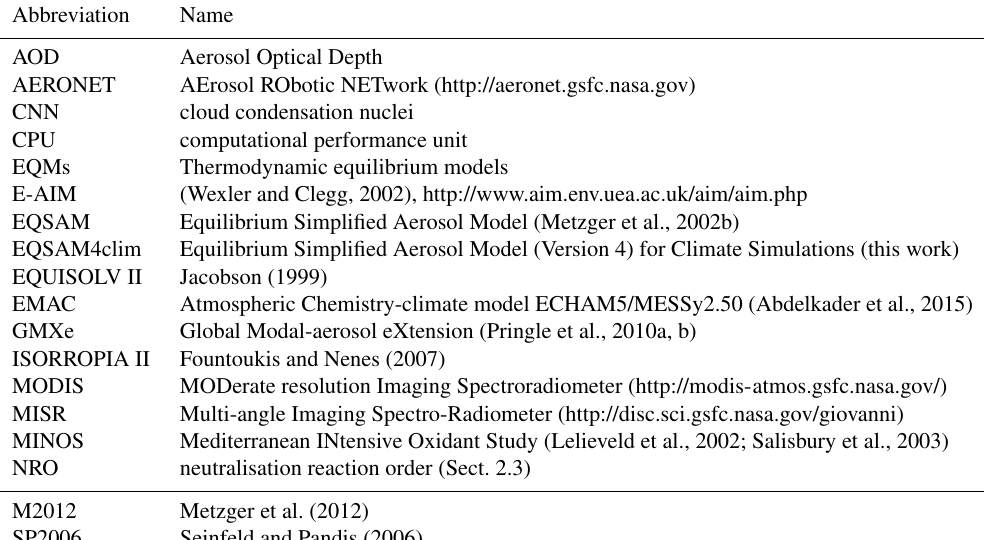
Figure A1. Single solute molality as a function of water activity for several electrolytes: (NH 4 )HSO 4 , NaHSO 4 , NH 4 NO 3 , NaNO 3 (at T = 298 . 15K) calculated with EQSAM4clim from Eqs. (A3) and (A6) compared to tabulated molality and RHD measurements of ISORROPIA II used to determine ν i . Table A1. List of names and